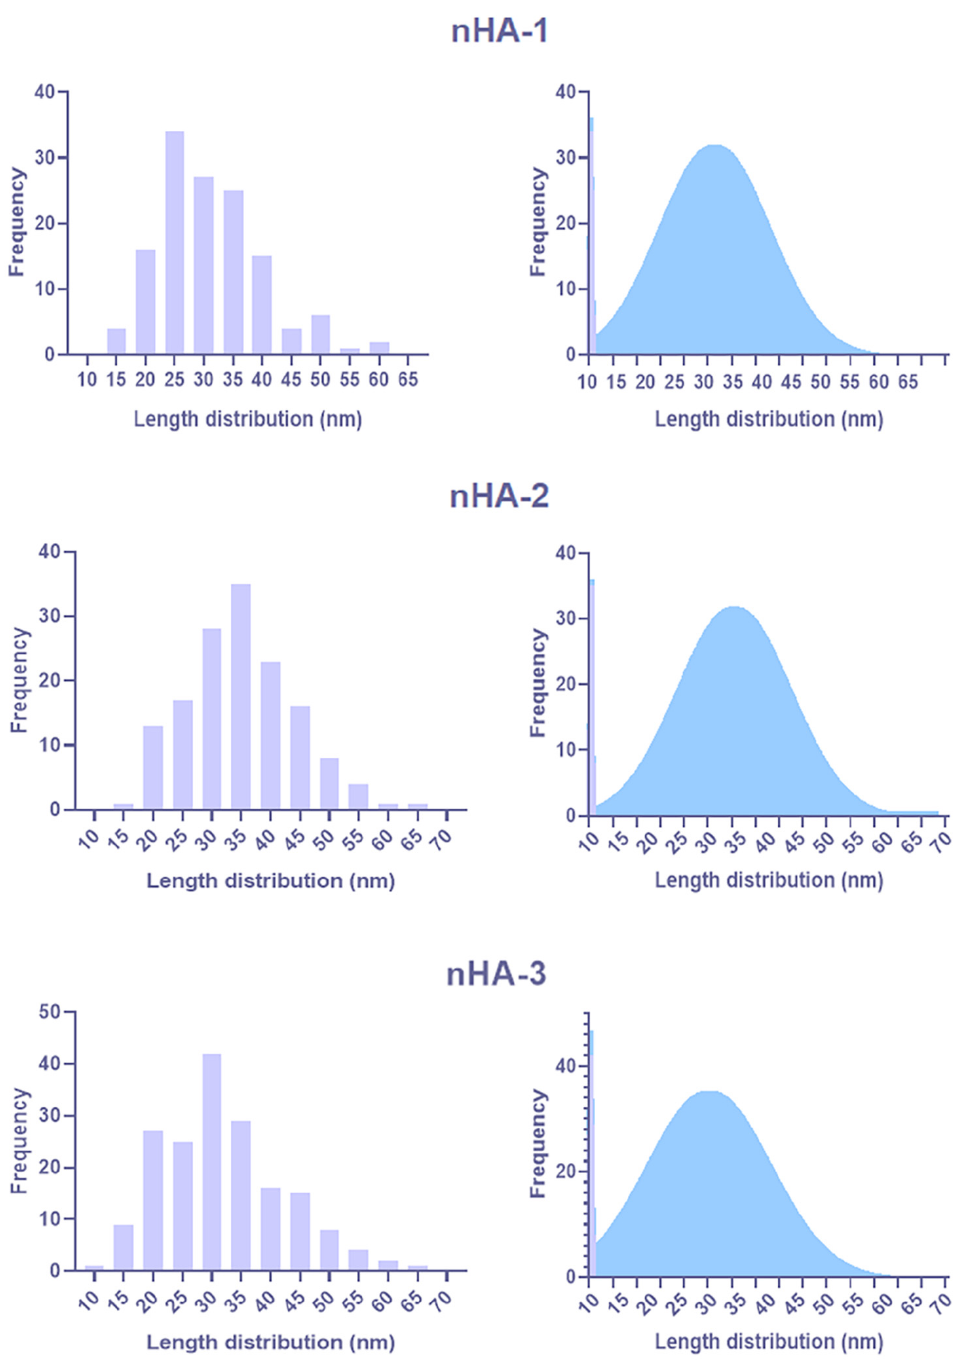
Figure 2. Particle size distribution determined using image analysis of TEM images. The size distribution is presented as histograms (left) and the correspondent Gaussian curves (right).